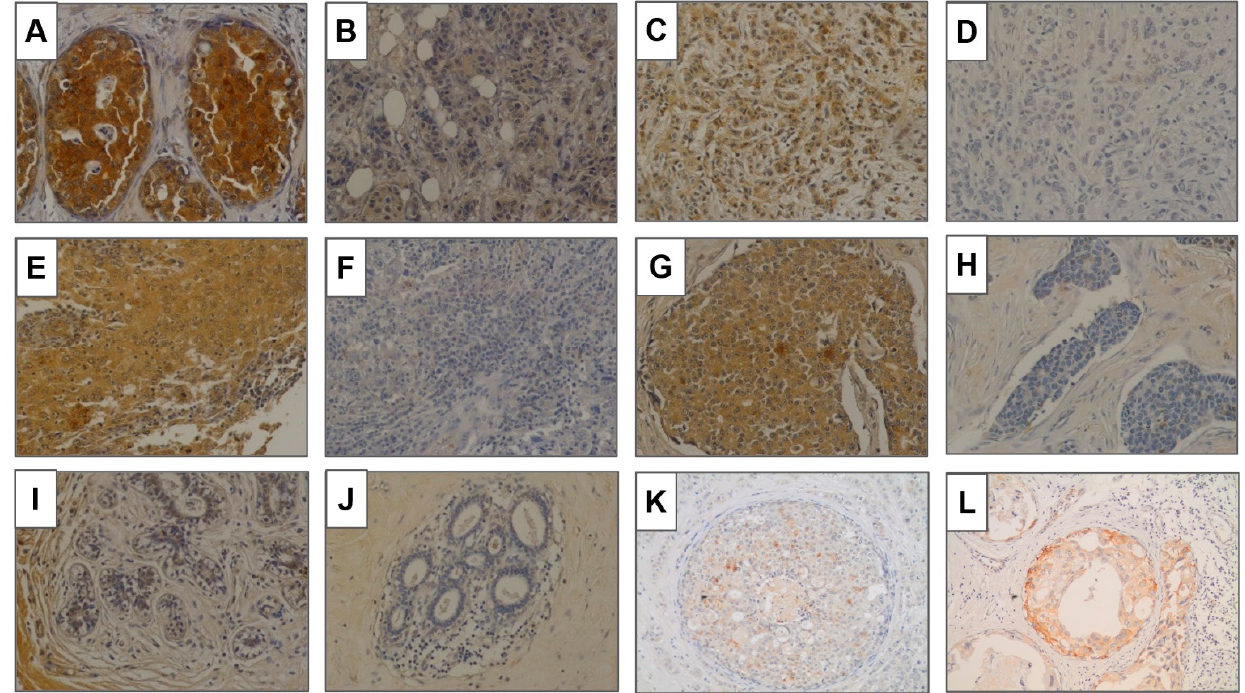
Figure 4. GalNAc-T13 expression in breast tissues. ( A , B ) Positive and negative expression, respectively, in invasive ductal carcinoma. ( C , D ) Positive and negative expression in lobular carcinoma. ( E , F ) Positive and negative expression in invasive carcinoma with medullary features. ( G , H ) Positive and negative expression in carcinoma with neuroendocrine features. ( I , J ) Normal breast tissue adjacent to breast cancer. ( K , L ) Ductal carcinoma in situ of low grade and high grade. Magnification of all pictures: 200 × .